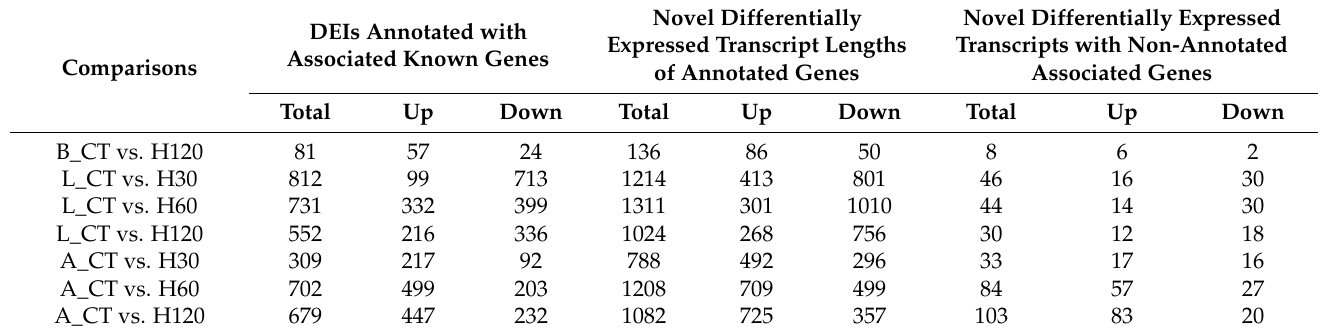
Table 1. Summary of DEIs identified in blood, liver, and adrenal glands of rats under heat